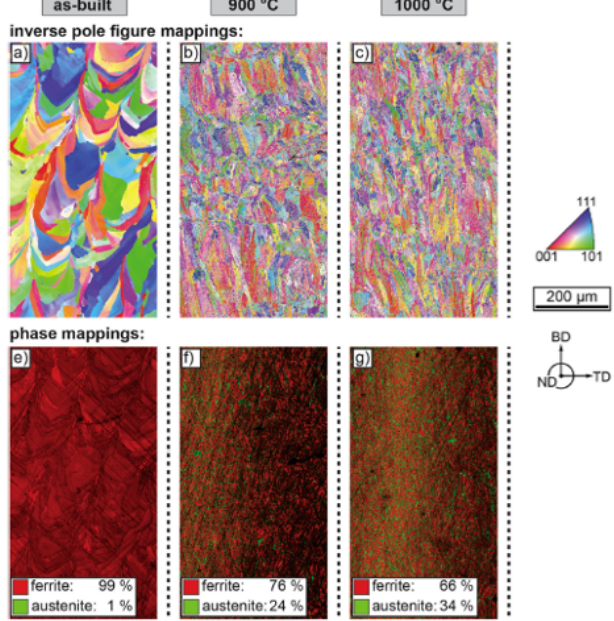
Figure 19. EBSD maps of duplex 2205 showing ( a – c ) inverse pole maps and ( e – g ) corresponding phase fraction, in ( a , e ) as-built condition, ( b , f ) after annealing at 900 °C, and ( c , g ) after annealing at 1000 °C [146], with permission from Elsevier, 2019. Table 6. Tensile strength of duplex stainless steel alloys obtained from L-PBF, compared to standard reference values.